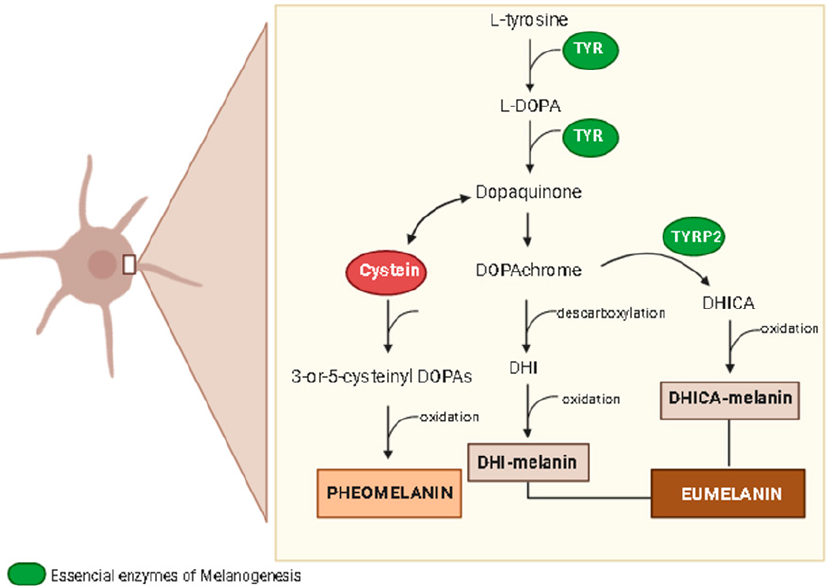
Figure 4. Synthesis of melanin. DHI, 5,6-dihydroxyindole; DHICA, DHI-2-carboxylic acid; L - DOPA, to L -3,4-dihydroxyphenylalanine; TYR, tyrosinase; TYRP2, tyrosinase-related protein-2. The illustration was drawn using Biorender software.